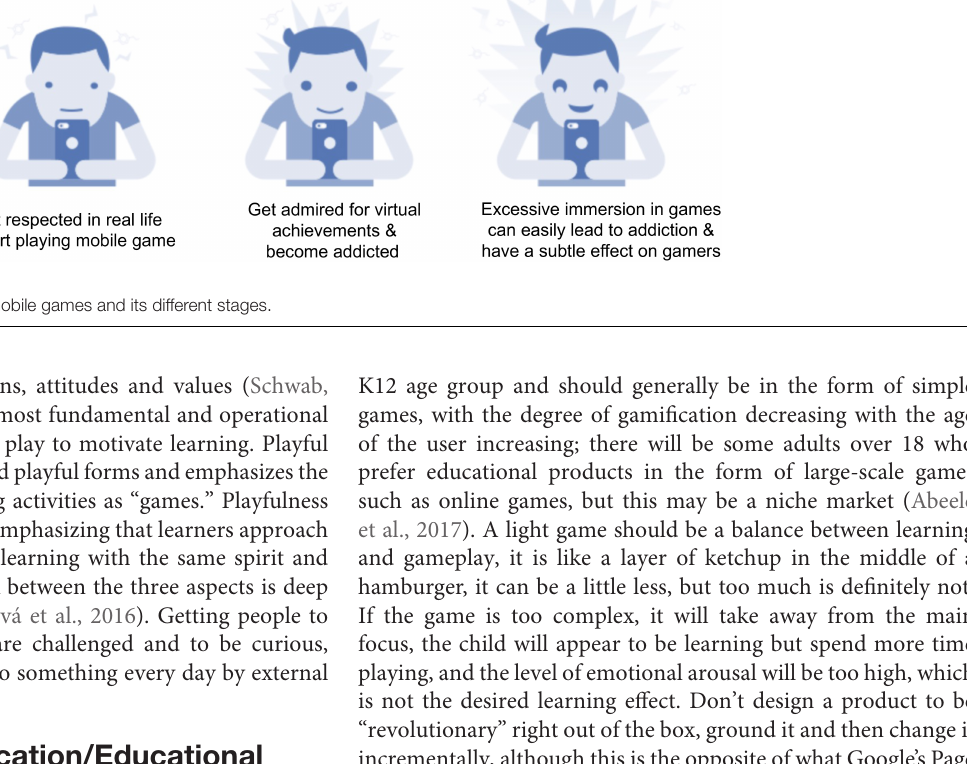
of knowledge, ability, emotions, attitudes and values (Schwab, 2018). Play motivation is the most fundamental and operational value, emphasizing the use of play to motivate learning. Playful thinking suggests going beyond playful forms and emphasizes the design of non-playful learning activities as “games.” Playfulness is the most meaningful value emphasizing that learners approach the process and outcomes of learning with the same spirit and attitude as play. The core link between the three aspects is deep intrinsic motivation (Škaˇrupová et al., 2016). Getting people to do something because they are challenged and to be curious, rather than being pushed to do something every day by external rewards and pressures.